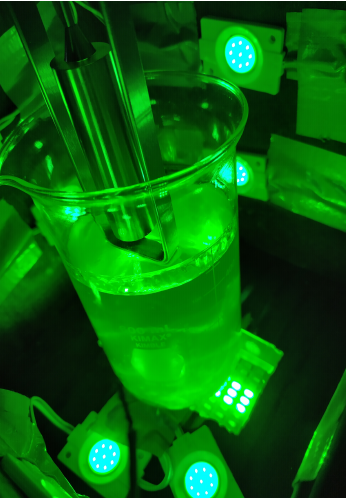
Figure 4. The 12 LEDs were coupled around the closed box while the LED lamp was installed under it. This closed box was then coupled to the DV-I Prime viscometer.